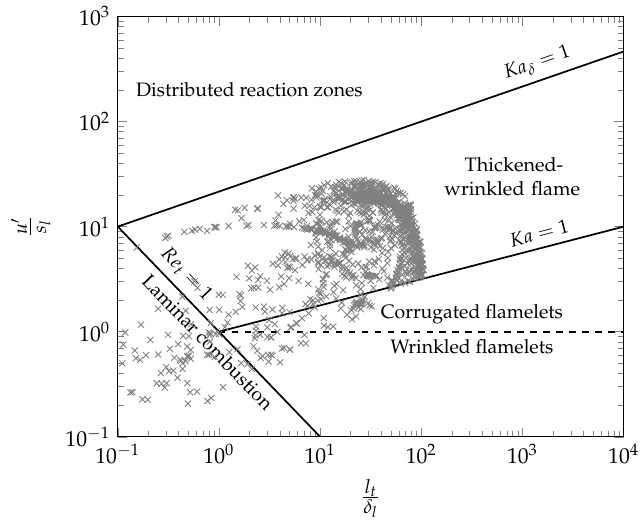
Figure 18. Regime diagram (as proposed by Peters [19]) with scatter based on FGM-NAC . Figure 14. Regime diagram (as proposed by Peters [20]) with scatter based on A combustion regime diagram gives insight in the various regimes that a turbulent flame can reside in. To check whether the assumptions made in the derivation of the FGM model are valid, a scatter plot of all points in the fluid domain is mapped on the regime diagram and as result, the local flame regime can be estimated. For the plot, the laminar flame speed and flame thickness are based on the adiabatic flamelet solution calculated by Chemkin PREMIX , which is used in the FGM database. The laminar flame speed equals 0.068 meters per second. The flame thickness is based on the definition using the temperature gradient [20]: δ l = T b − T u max (cid:16) d T d x (cid:17) , (15) which yields a value of 3e-4 metres. The velocity fluctuations are estimated as u 0 ≈ q 2 3 k 334 and the integral turbulent length scale as l t ≈ k 3/2 e − 1 . This gives the plot as shown in fig. 335 18. The diagram shows that the combustion falls mainly in the thickened flame regime. 336 This result is in agreement with unsteady simulations on this burner configuration 337 [9–11], where turbulence was seen to impact the combustion significantly. This result 338 does mean that the assumption that the flame resides in the flamelet regime is not 339 strictly valid. The plot must only be seen as an order of magnitude approximation, 340 however. The definition of u 0 is based on isotropic turbulence, which is not accurate in 341 the flame front. The regime of flameless combustion, which this setup is designed for, is 342 normally associated with the distributed reaction zones area (top right of the diagram) 343 [1]. The current simulation of the flame show data points that are in between the lines 344 Ka = 1 and Ka δ = 1, which is the transition zone between flamelet and distributed 345 reaction zones. The contour and profile plots in the previous sections show that the 346 model is able to predict velocity and temperature well. The FGM model in combination 347 with the k − ω SST turbulence model provides satisfactory results for these variables. 348 However, the flame length is underpredicted, and more specific to the FGM model the 349